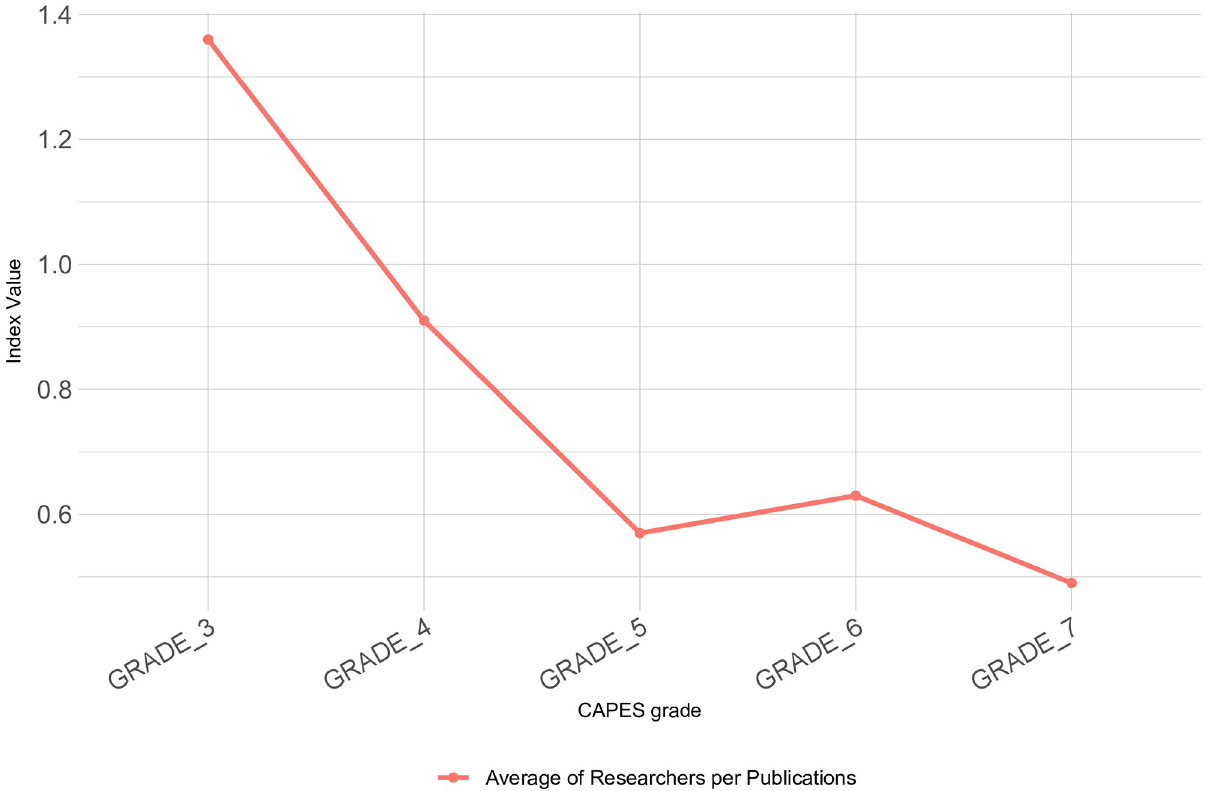
Fig 7. Average number of researchers per publication in graduate programs regarding their CAPES grades.